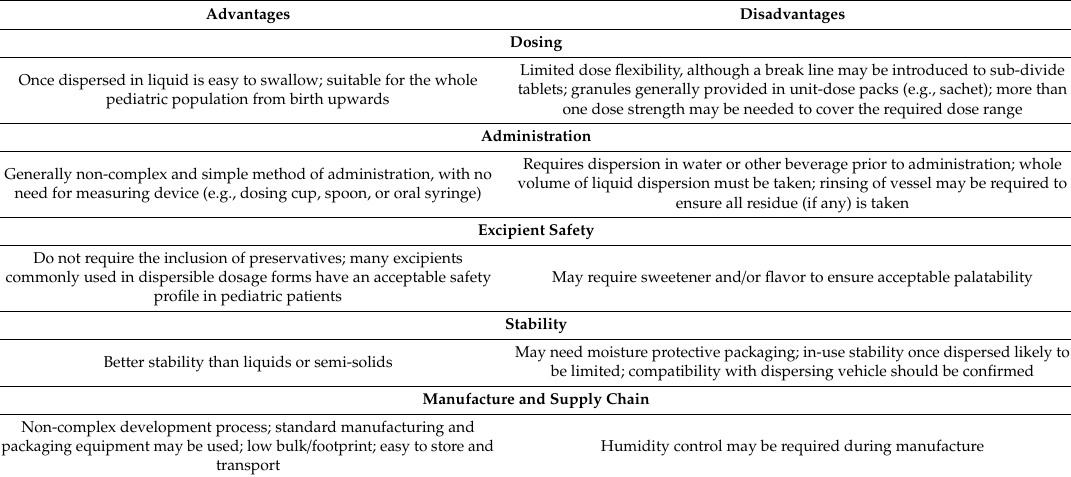
Table 2. Advantages and disadvantages of oral dispersible dosage forms.